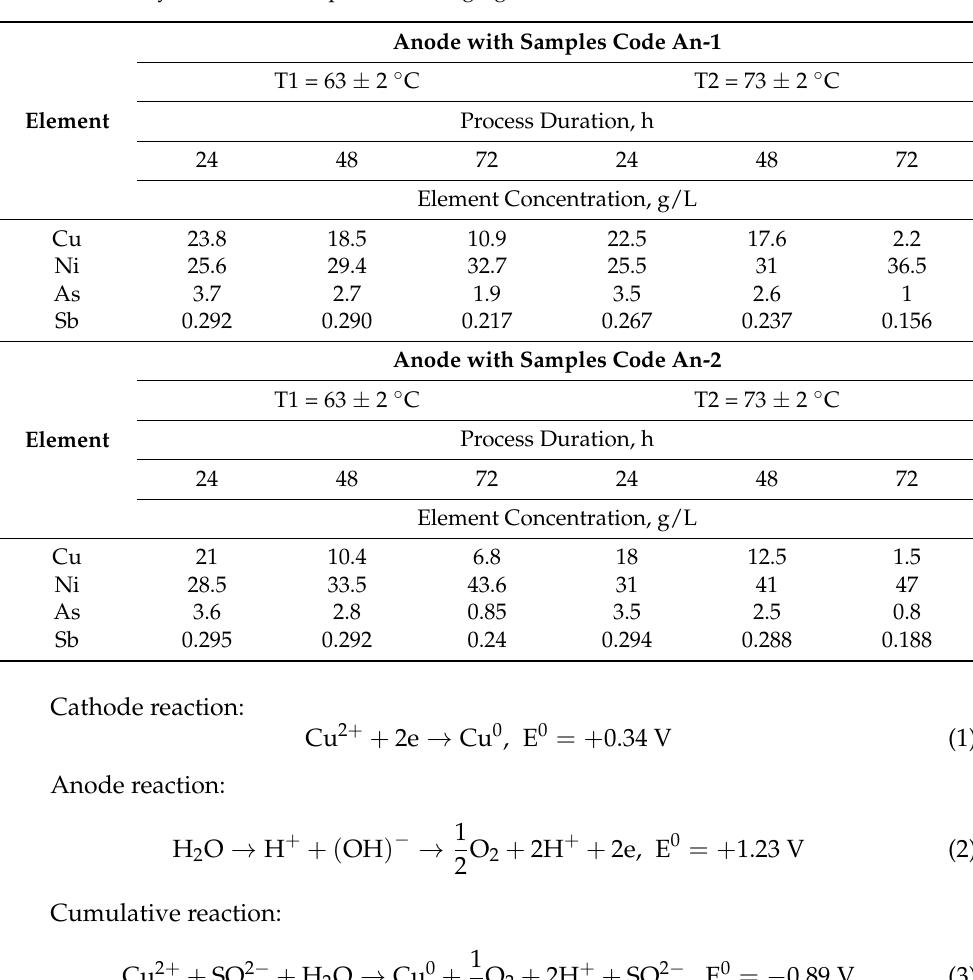
Table 3. Electrolyte chemical composition